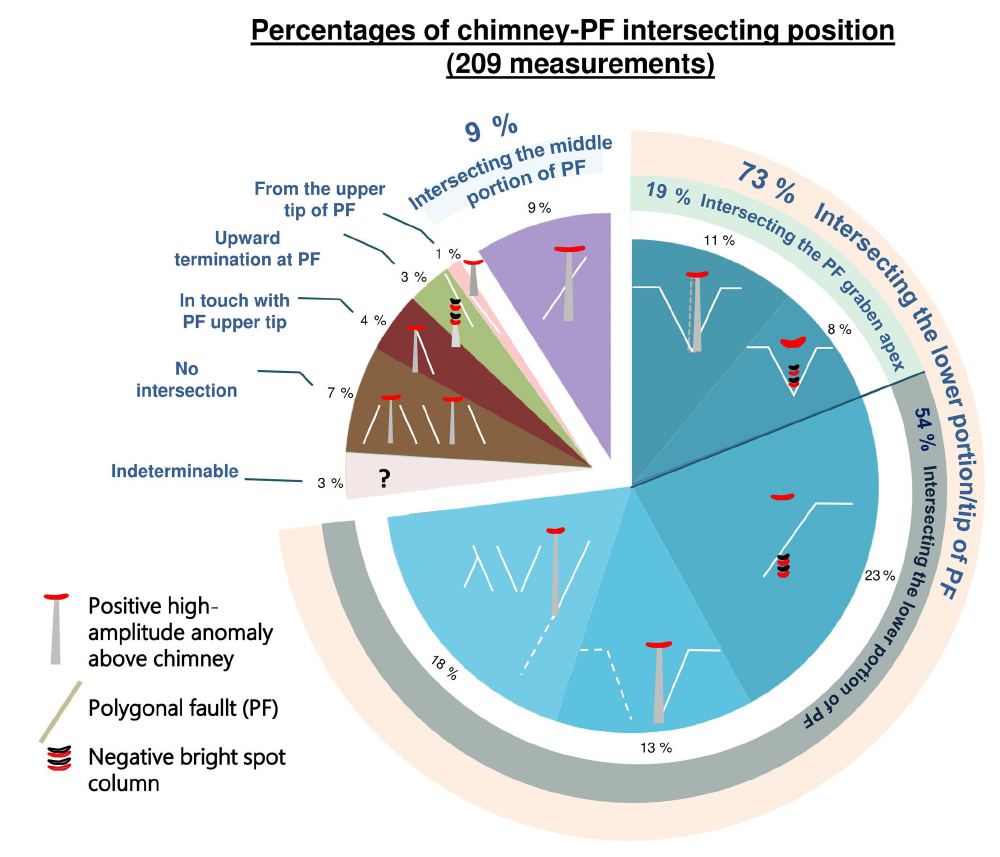
Figure 12. Pie charts showing the percentage of chimneys intersecting or emanating from different parts of fault planes or adjacent fault blocks. The position of the chimney–fault intersections are illustrated with cartoons in each pie segment. See key at bottom left for drawing codes. Image modified from Ho (2013).